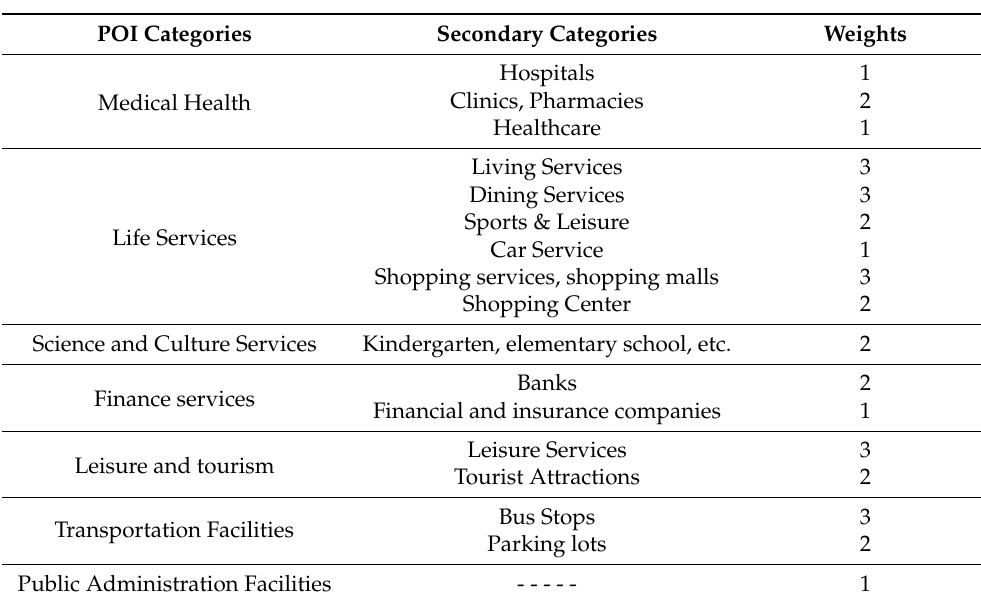
Table 2. POI activity weights